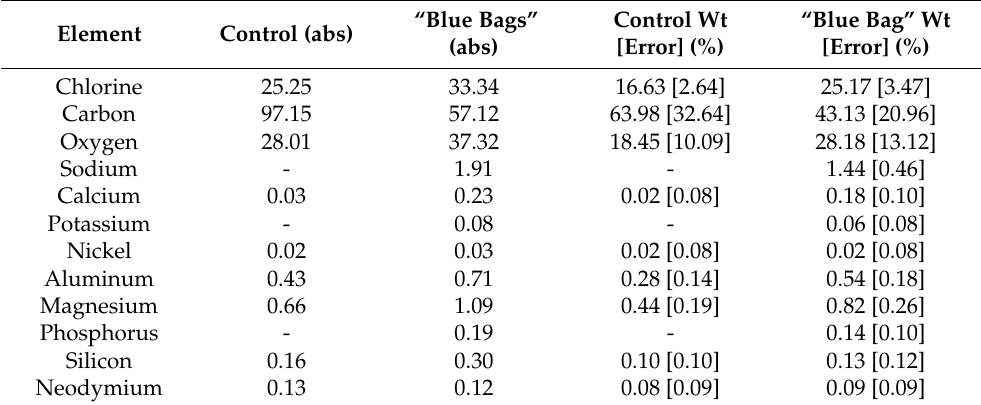
Figure 2. Morphological images of urine drainage bag obtained using the scanning electron microscope. On the left side, the clean bag (control); on the right side, the “blue” bag. The EDX analysis was applied to detect the elemental composition of the bag both before (control) and after the use by the patient (“blue bags”). The results of the EDX analysis are reported in Table 2. EDX provides elemental data in both atomic and weight percentages automatically through the built-in software. The major components of the control bag and samples were Cl, C and O. In the sample bags Ca and P, and small traces of K, were also detected. In the “blue bag” sample, it is possible to notice an increase in the amount of chlorine, oxygen, magnesium and calcium, compared to the control one. Table 2. Results of EDX analysis.